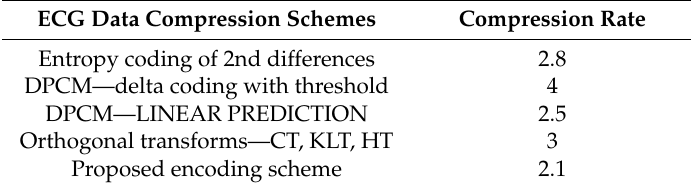
Table 4. Lossless compression rate method. DPCM: differential pulse-code